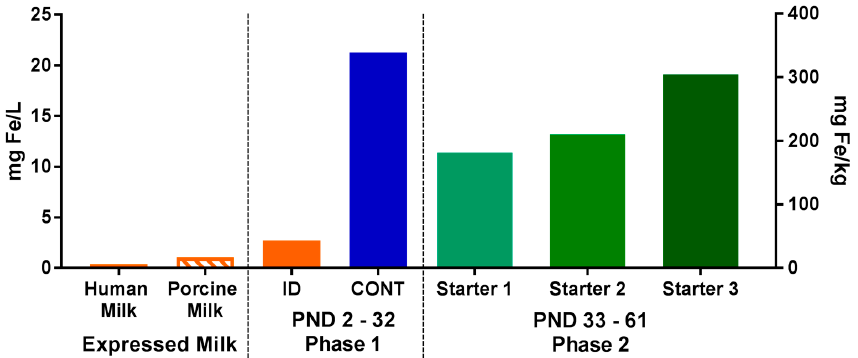
Figure 1. Analyzed concentrations of iron in porcine and human milks, as well as in dietary treatments during both phases of the pig study. During phase 1, pigs were fed either a control (CONT) or iron-deficient (ID) milk replacer. The CONT treatment contained 21.3 mg/L (106.3 mg/kg), and the ID treatment contained 2.72 mg/L (13.6 mg/kg). The ID treatment closely resembled the average iron content of porcine milk ( n = 7; 1.06 mg/L) collected during a prior study [18], and is comparable to the iron concentration of human milk [7,19]. During phase 2, all pigs were fed a series of standard commercial starter diets (180–300 mg/kg). Abbreviations: CONT, control; ID, iron deficient; PND, postnatal